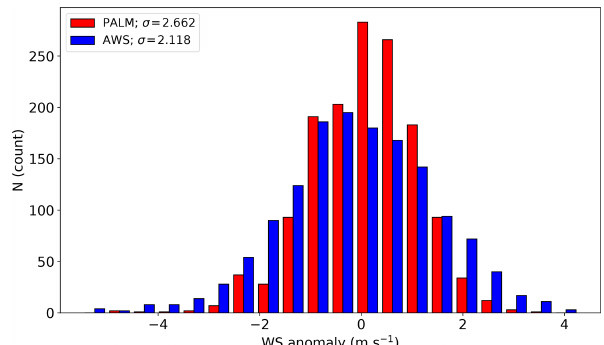
Figure 8. Comparison of the range and distributions of hourly wind speed anomalies between PALM and the observational data (la- belled as AWS) for the 24h period of the north-westerly case. σ is the standard deviation of the anomaly data.